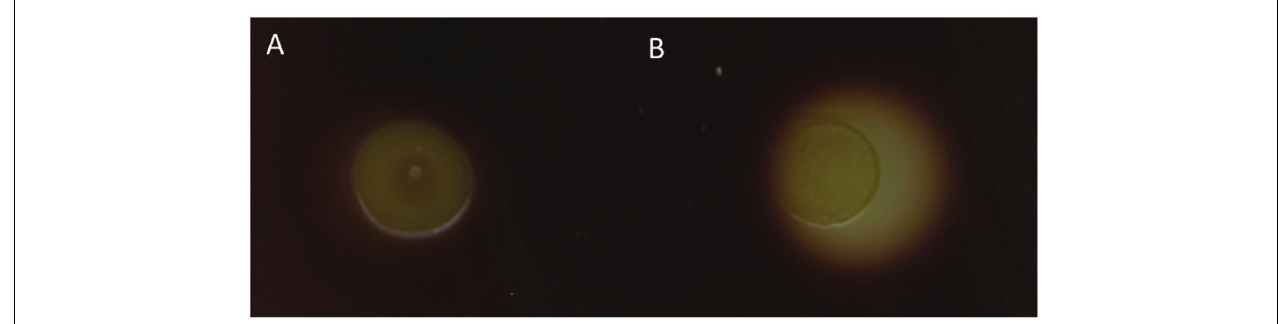
FIGURE 9 | Starch degradation by B. methanolicus strains. The strains were grown on LB plates supplemented with 0.5% starch and 0.05% xylose and iodine added to detect starch degradation. The dark area in the plate indicates presence of starch and the colorless halo around cells indicates starch degradation. (A) B. methanolicus MGA3 (pTH1mp) and (B) B. methanolicus MGA3 (pTH1xpx- amy